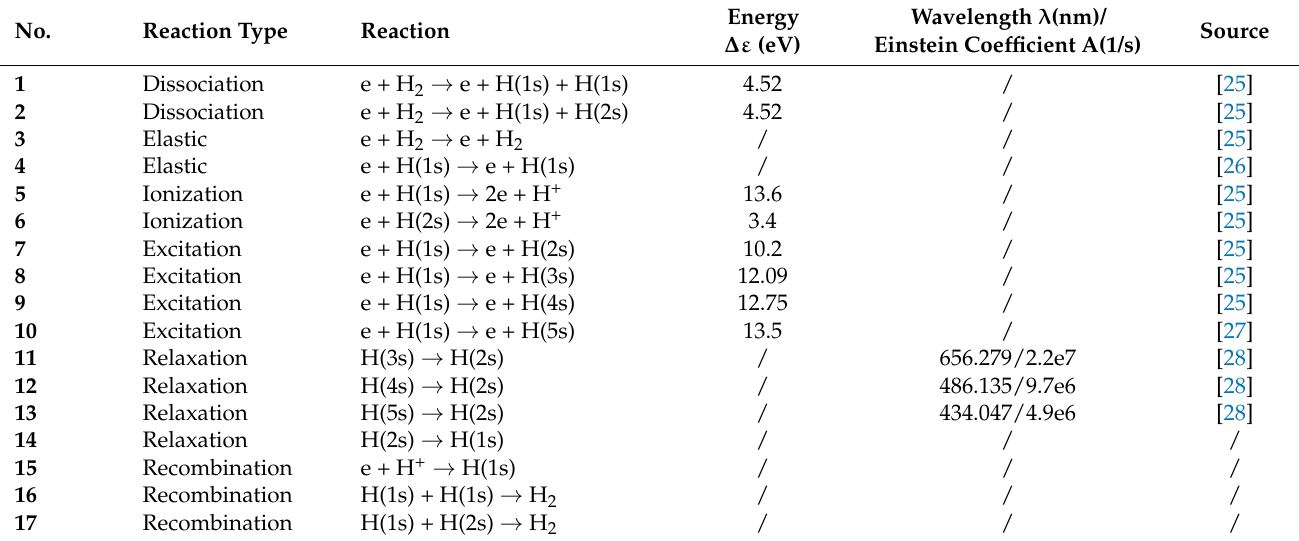
Table 3. Reactions in hydrogen